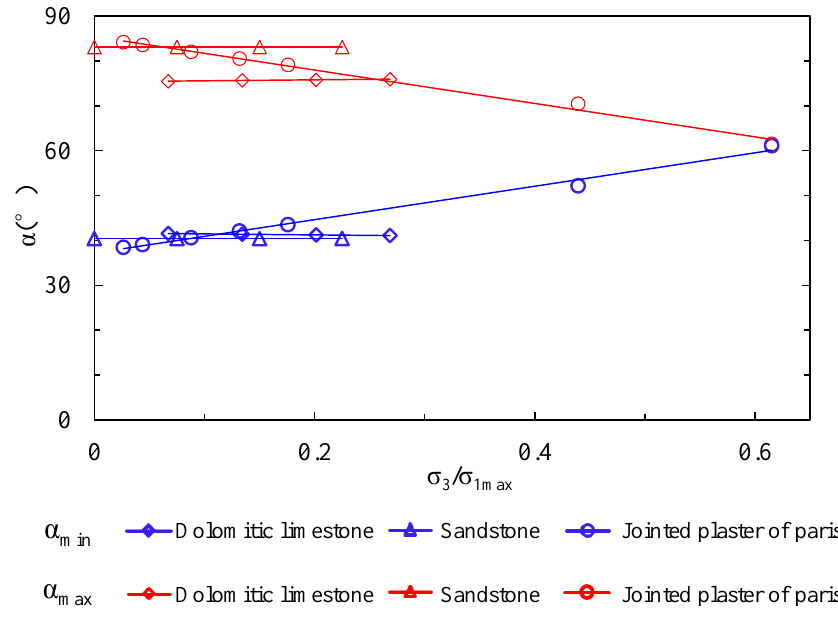
Figure 7. The relation between possibility of anisotropic structural plane-controlled failure and confinement.